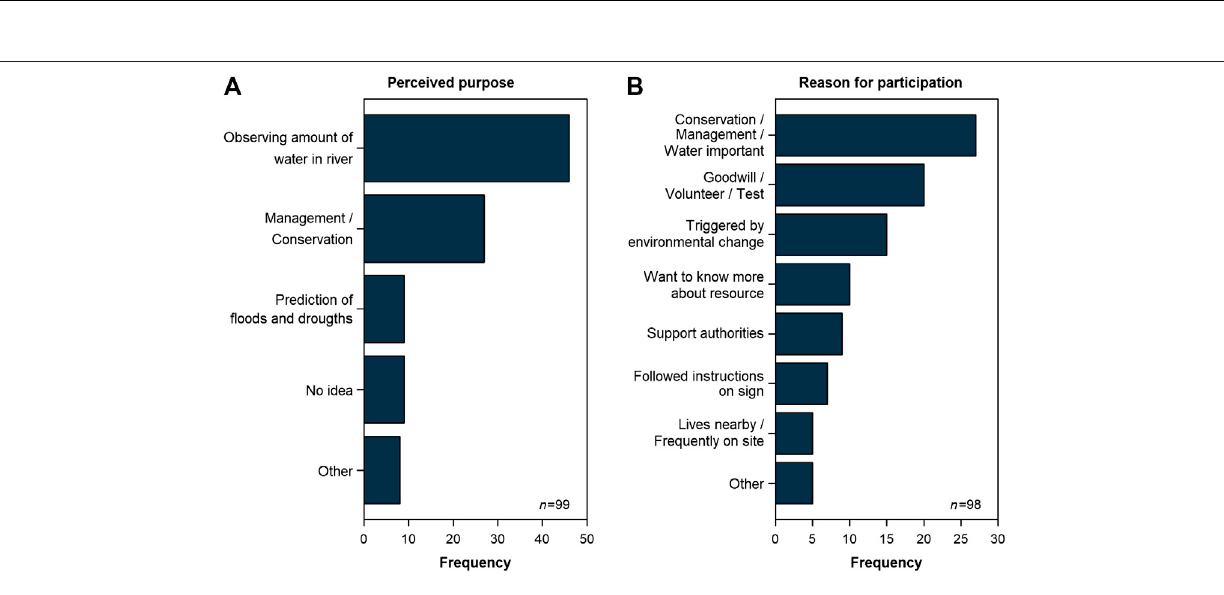
Frontiers in Earth Science |